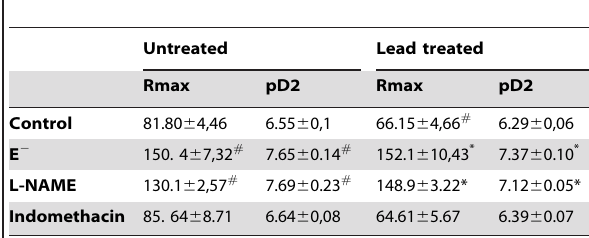
Table 1. Parameters of maximal response (R max ) and sensitivity (pD 2 ) of the concentration-response curves to phenylephrine in the aortas from untreated and lead-treated rats, before (E + ) and after (E 2 ) endothelial damage and after N G -nitro-L-arginine methyl ester (L-NAME, 100 m M) and indomethacin (10 m M)